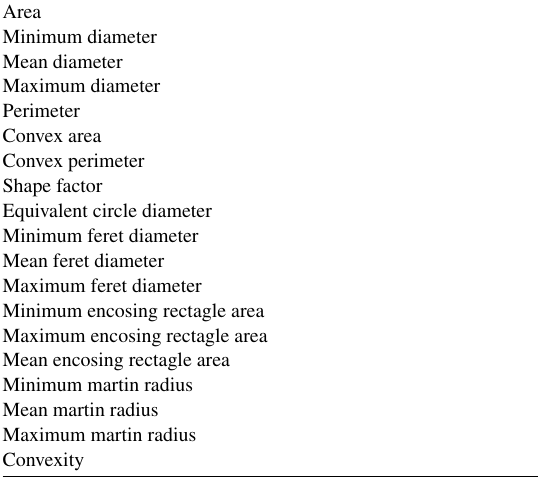
List of the parameters used in the study